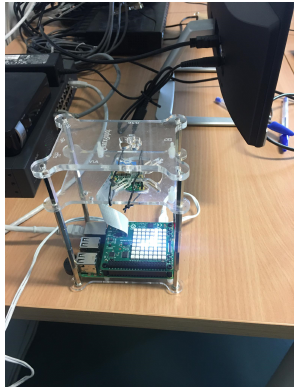
Figure 8. Example of individual Raspberry Pi device.